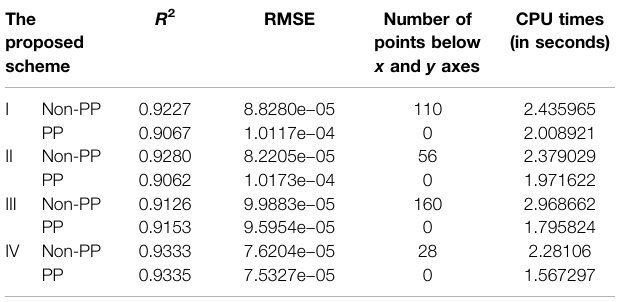
TABLE 9 | Error estimation. The